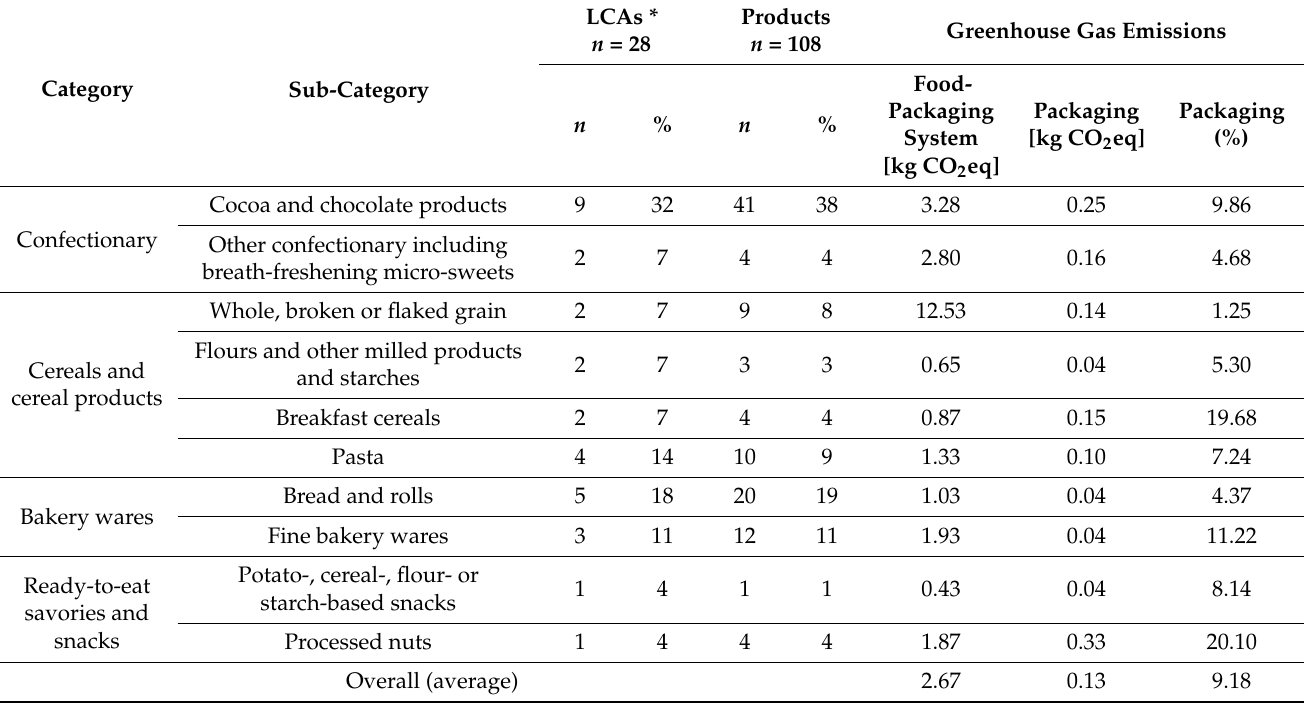
Table 1. Reviewed cereal and confectionary life cycle assessment (LCA) studies ( n =